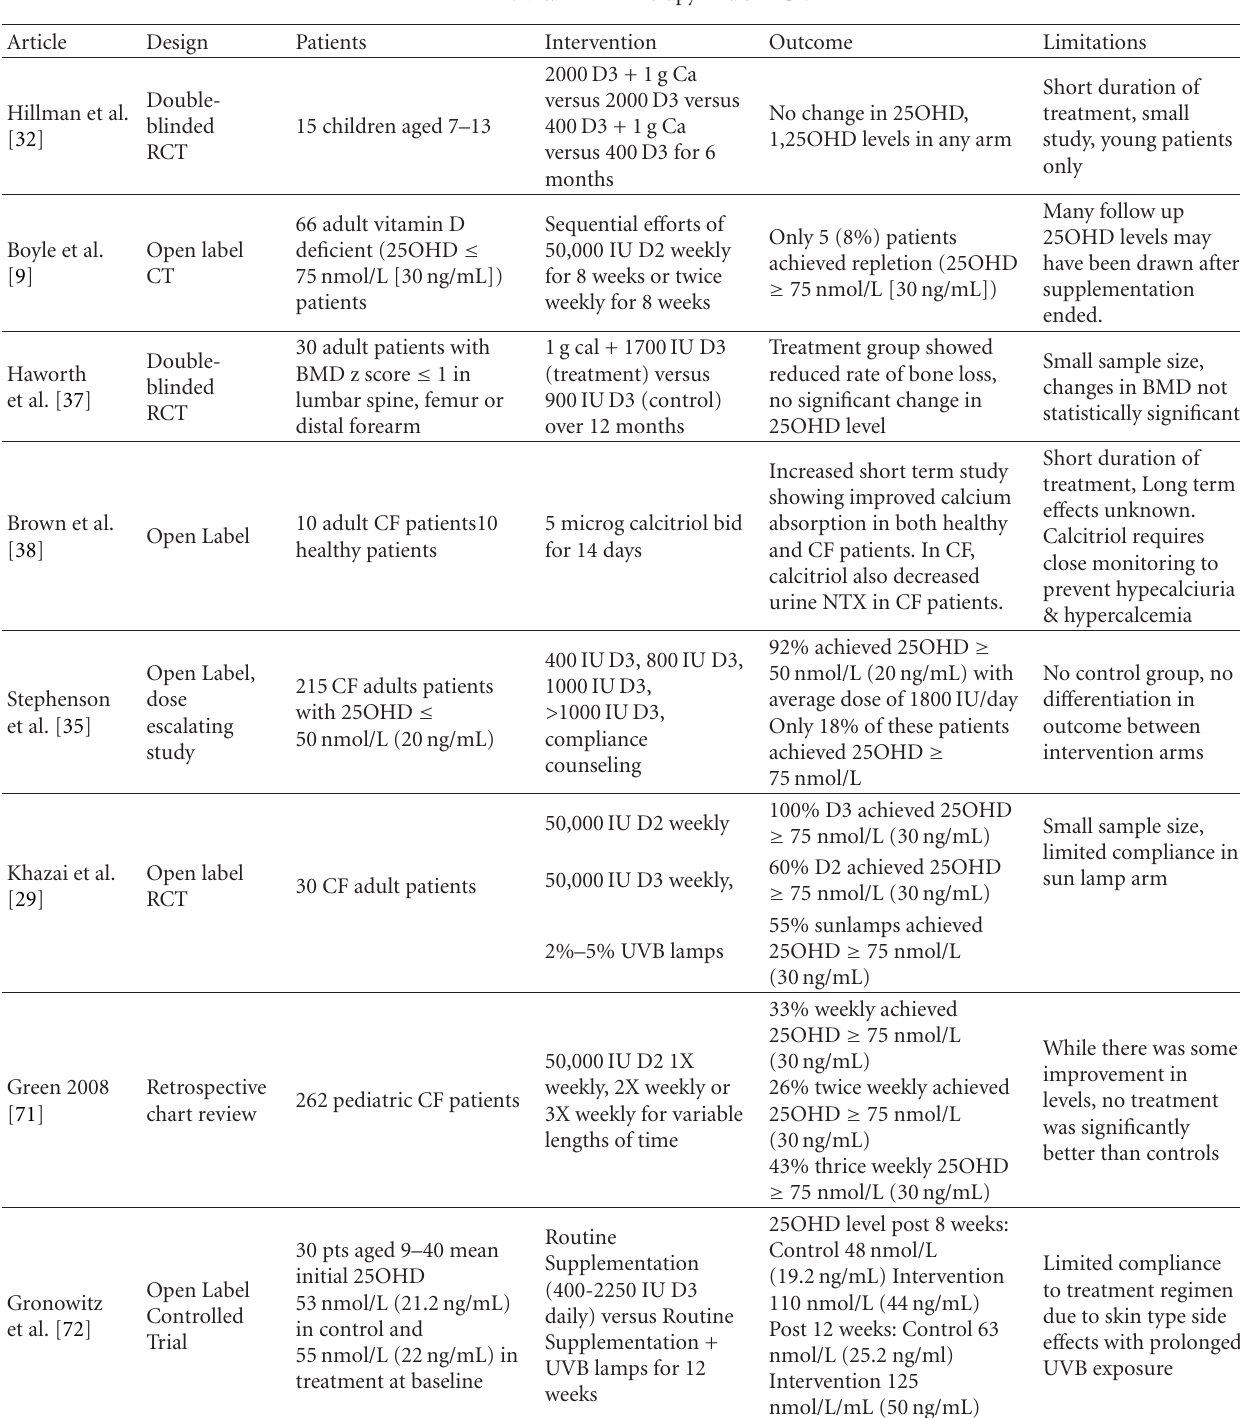
Table 2: Vitamin D Therapy Trials in